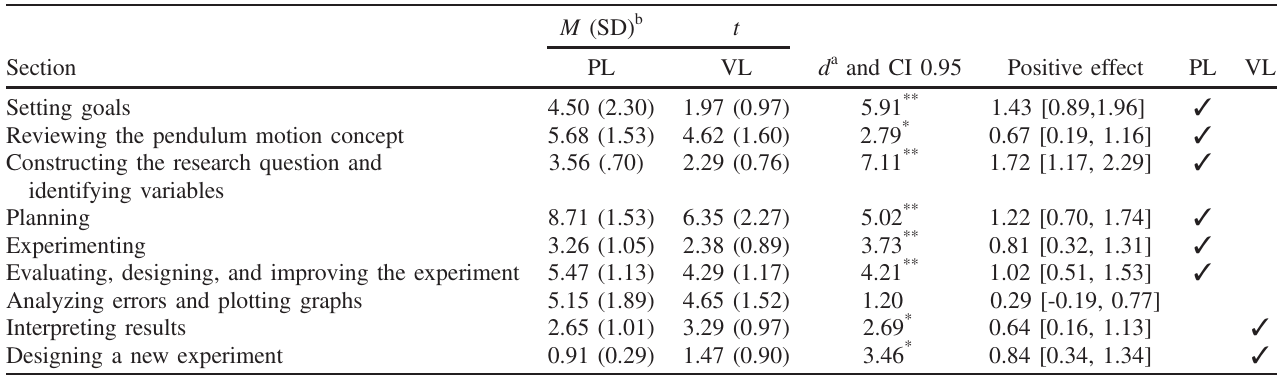
TABLE III. Comparison of students ’ IP.